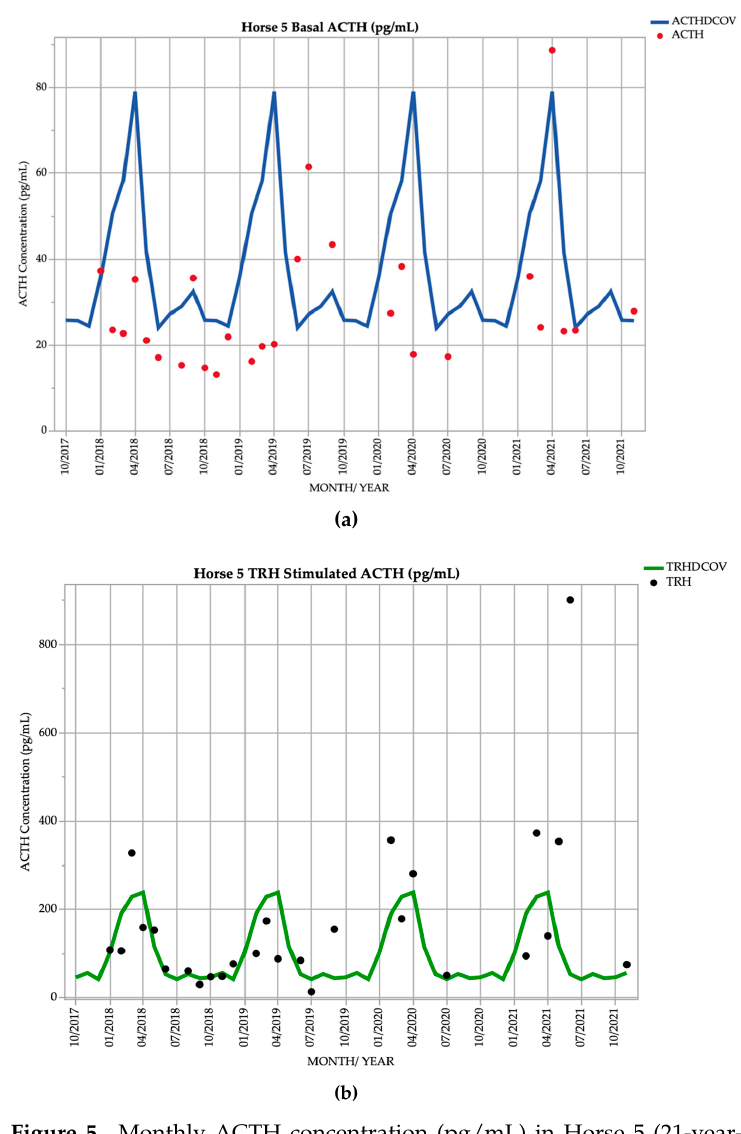
Figure 5. Monthly ACTH concentration (pg/mL) in Horse 5 (21-year-old Standardbred mare), compared to locally derived, seasonally adjusted DCOV [2]. (a) Basal ACTH concentrations (red points) and basal ACTH DCOV (blue line) (b) TRH ‐ stimulated ACTH concentrations (black points) and TRH ‐ stimulated ACTH DCOV (green line). Horse 5 suffered from recurrent corneal ulceration and suspected viral keratitis from September to November 2020. The condition resolved after a few months of treatment with chloramphenicol, ofloxacin, idoxuridine, atropine and phenylbutazone. 3.6. Horse 6